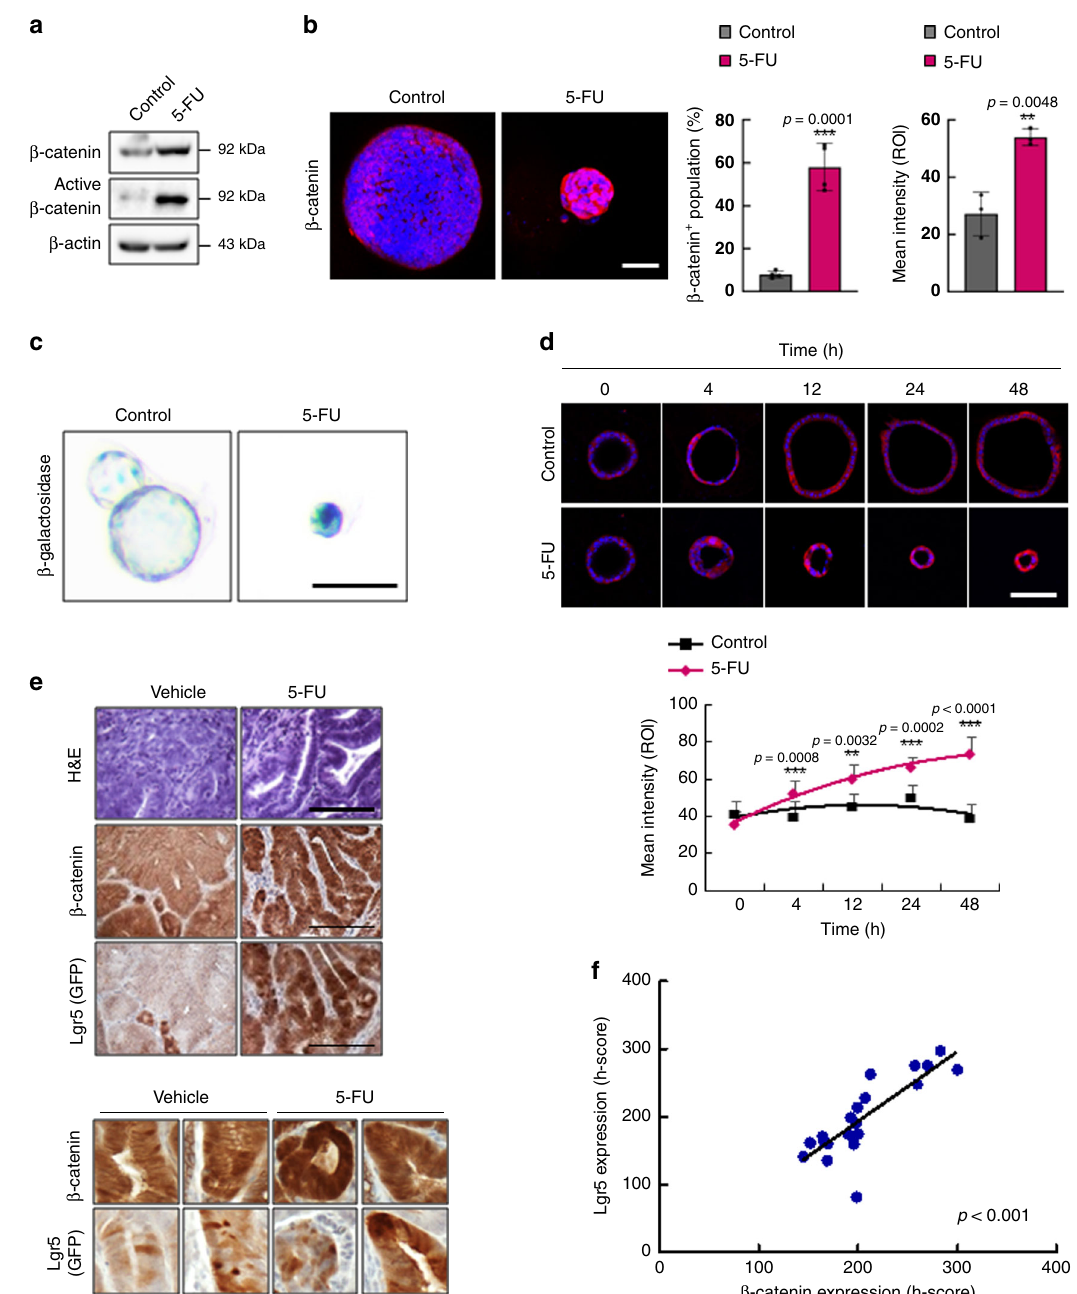
Fig. 2 5-FU activates the WNT/ β -catenin pathway in murine CRC. a Immunoblots of indicated proteins in Apc Min/ + /Lgr5 EGFP tumor organoids with or without 5-FU treatment (1.5 μ g/ml, 48 h). b Confocal images of β -catenin (red) in Apc Min/ + /Lgr5 EGFP tumor organoids with or without 5-FU treatment. The percentage of β -catenin / + cells ( n = 4 biologically independent samples per group) and the mean intensities ( n = 3 biologically independent samples per group) were quanti fi ed. Scale bar = 50 μ m. c β -galactosidase staining of the tumor organoids derived from Apc Min/ + /Axin2 LACZ mice with or without